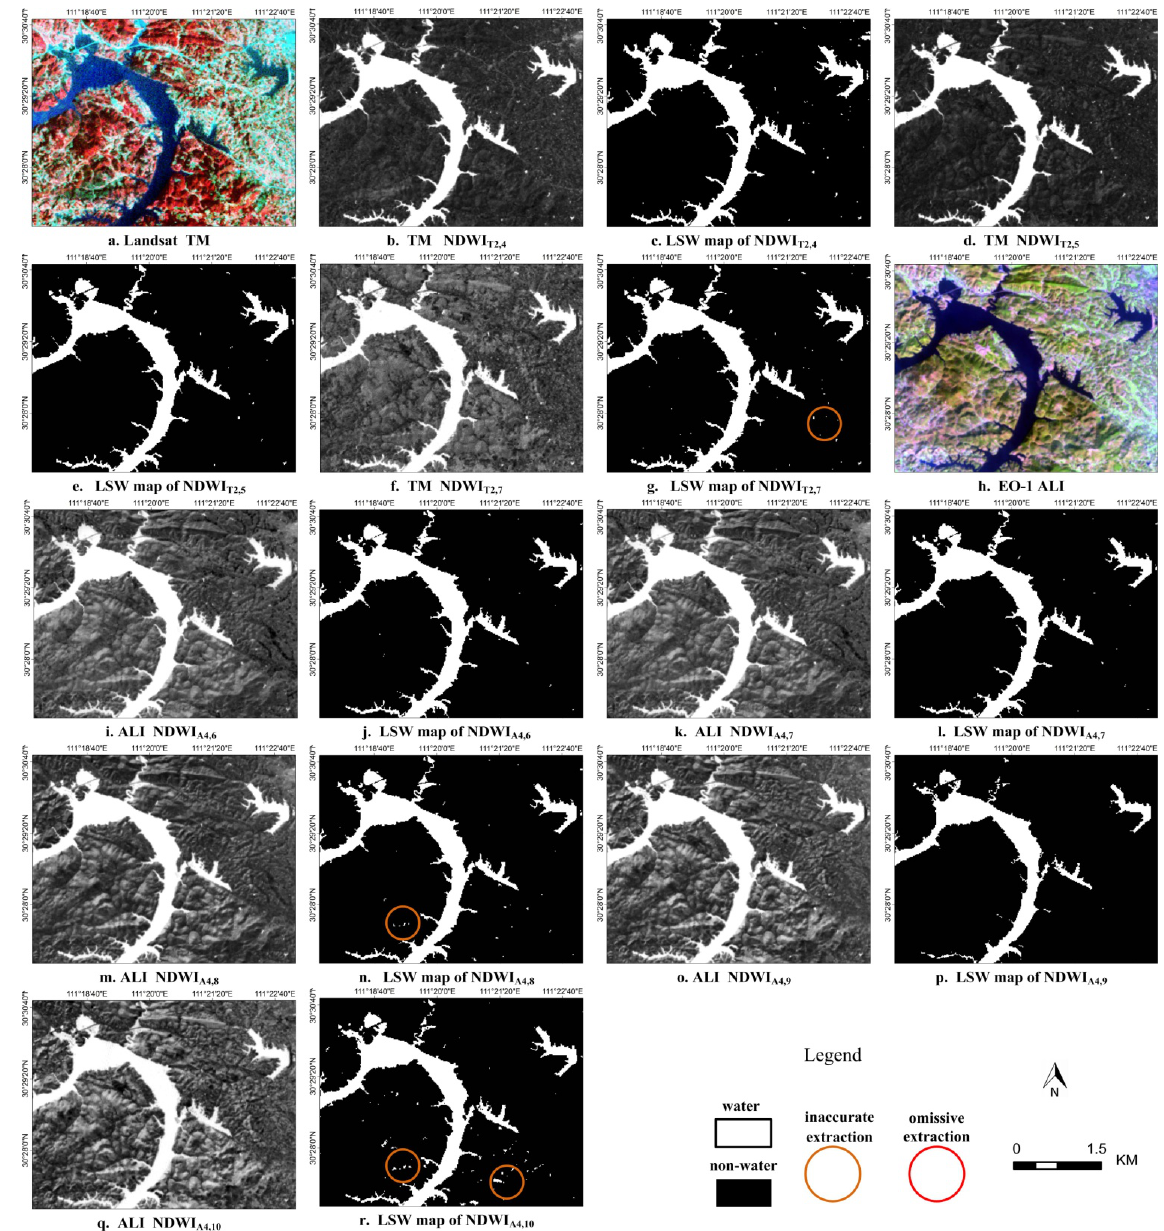
Figure 3. Original images and the LSW map results from Landsat TM imagery and EO-1 ALI imagery in Region II. ( a ) Landsat TM image (9 September 2005) false-color composite (RGB: 432); ( b ) NDWI calculated from TM Bands 2 and 4; ( c ) LSW map of ; ( d ) NDWI calculated from TM Bands 2 and 5; ( e ) LSW map of NDWI ; NDWI T2,4 T2,5 ; ( h ) EO-1 ALI ( f ) NDWI calculated from TM Bands 2 and 7; ( g ) LSW map of NDWI T2,7 image (21 October 2005) false-color composite (RGB: 965); ( i ) NDWI calculated from ; ( k ) NDWI calculated from ALI Bands 4 ALI Bands 4 and 6; ( j ) LSW map of NDWI A4,6 ; ( m ) NDWI calculated from ALI Bands 4 and 8; and 7; ( l ) LSW map of NDWI A4,7 ; ( o ) NDWI calculated from ALI Bands 4 and 9; ( p ) LSW map ( n ) LSW map of NDWI A4,8 ; ( q ) NDWI calculated from ALI Bands 4 and 10; ( r ) LSW map of NDWI of NDWI A4,9 A4,10